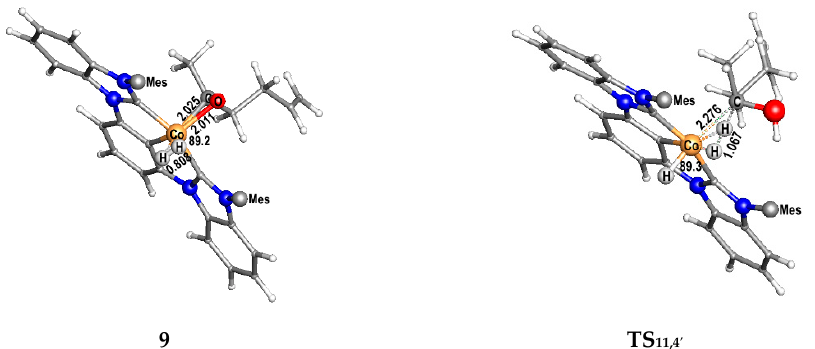
9 TS 11,4 ′ 9 TS 11,4 ′ Figure 4. Optimized structures of 9 and TS 11,4 ′ (1095 i cm − 1 ). Mesitylene groups are omitted for clar- Figure 4. Optimized structures of 9 and TS 11,4 ′ (1095 i cm − 1 ). Mesitylene groups are omitted for clar- Figure 4. Optimized structures of 9 and TS 11,4 (cid:48) (1095 i cm − 1 ). Mesitylene groups are omitted for Figure 4. Optimized structures of 9 and TS 11,4 ′ (1095 i cm − 1 ). Mesitylene groups are omitted for clar- ity. Bond lengths are in Å, and bond angles are in °. ity. Bond lengths are in Å, and bond angles are in °. clarity. Bond lengths are in Å, and bond angles are in ◦ ity. Bond lengths are in Å, and bond angles are in °.